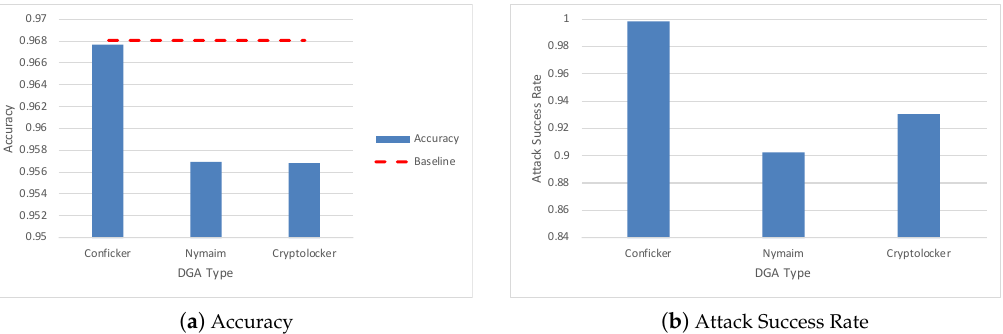
Figure 4. ( a ) The BA of Ngram-trigger backdoor attack based on different DGAs and ( b ) the ASR of Ngram-trigger backdoor attack based on different DGAs.